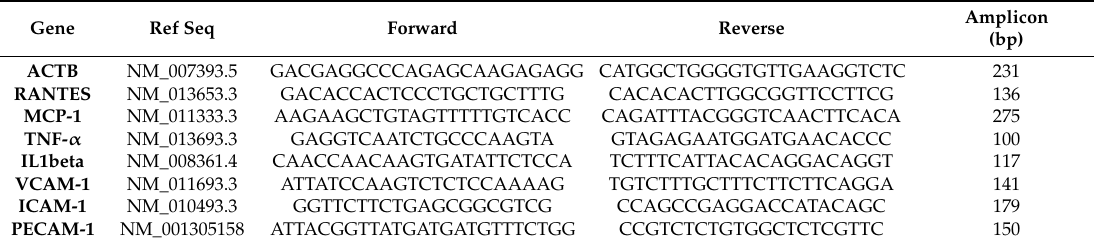
Table 1. Sequences of the primers for the murine genes whose expression was assessed in real time qPCR